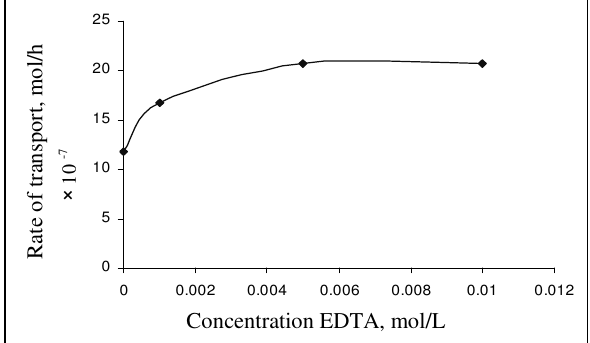
Figure 5. Effect of the ligand concentration on the rate of transport of